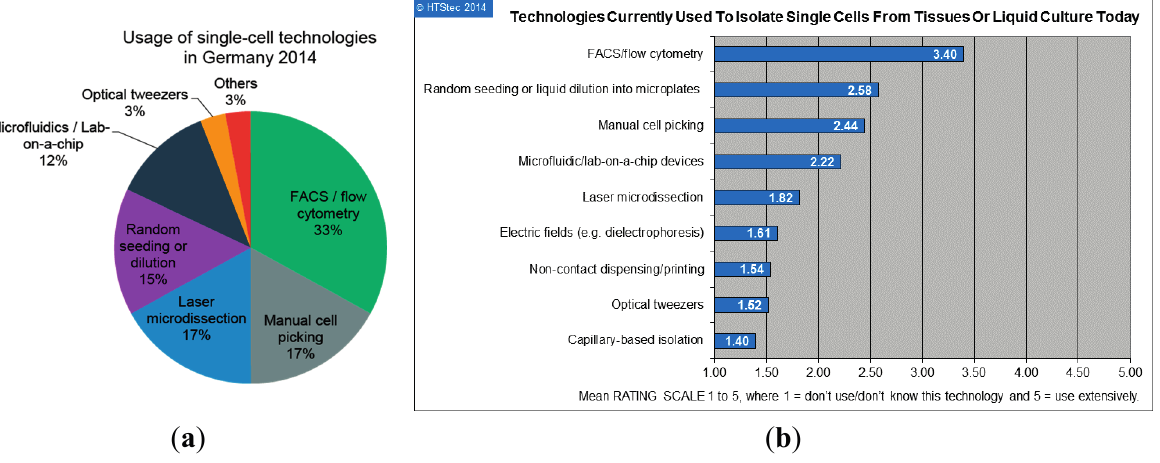
Figure 2. ( a ) The usage of technologies for handling single-cells in Germany in 2014. This